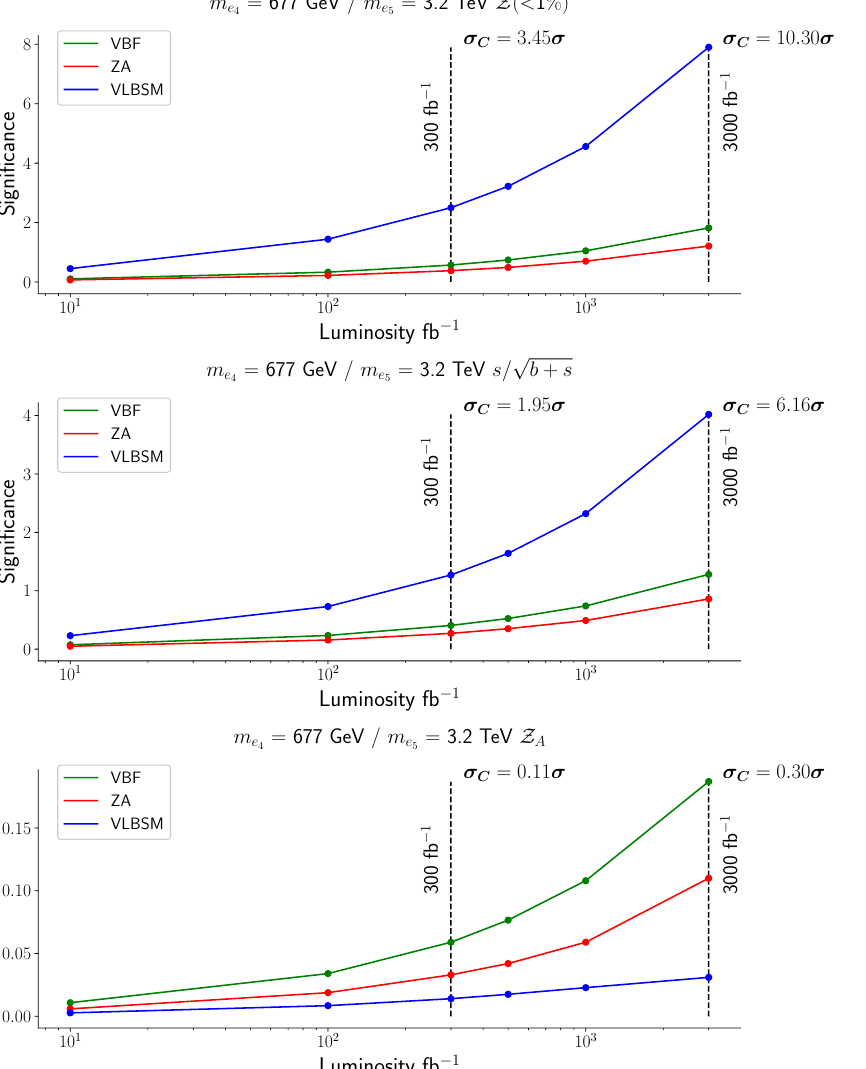
Figure 19. The same as in figure 17 but for a lightest VLL mass m = 677 GeV